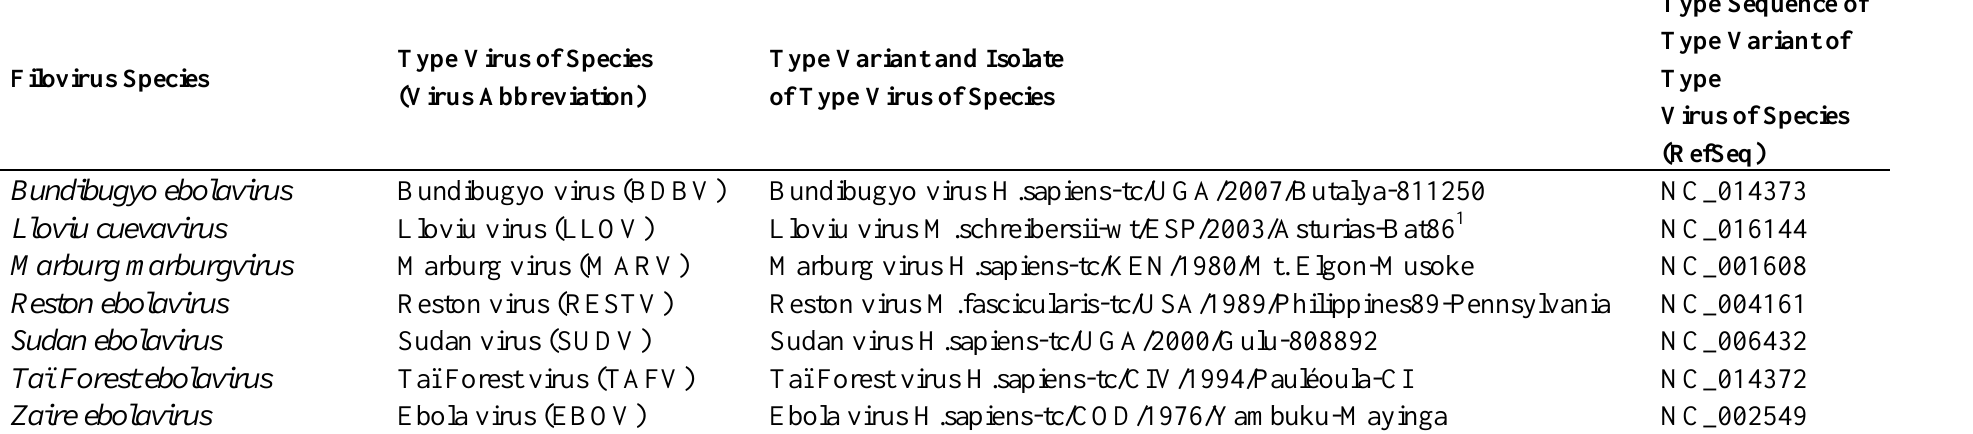
Table 3. Final filovirus type